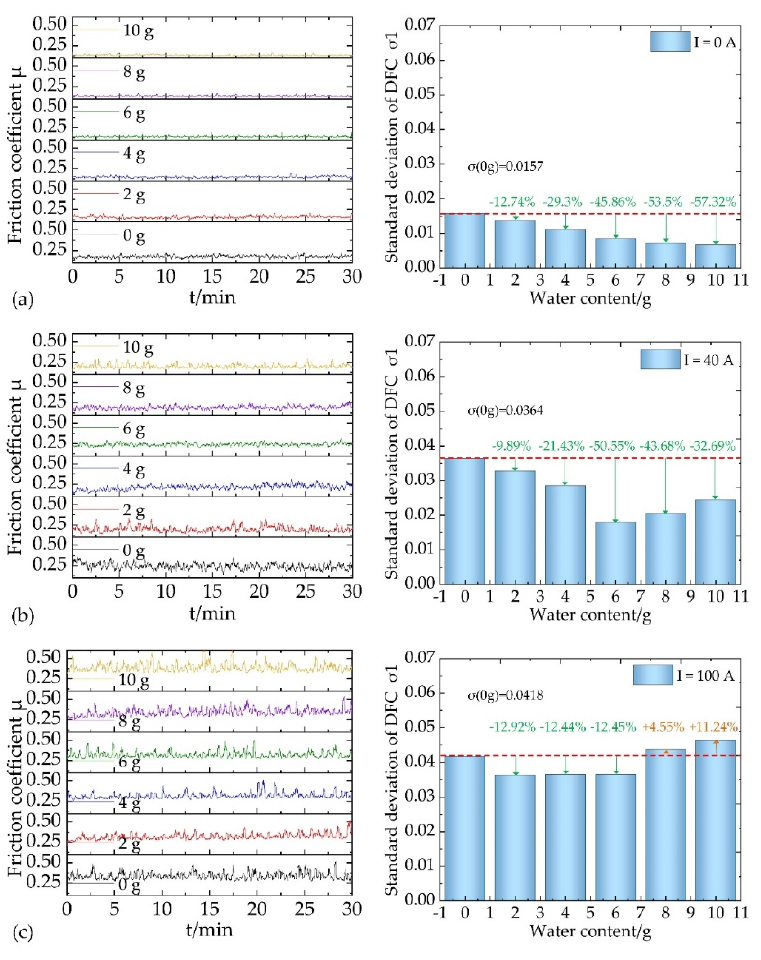
Figure 3. Effect of water content on the DFC of C-Cu contacts: ( a ) at 0 A; ( b ) at 40 A; ( c ) at 100 A.